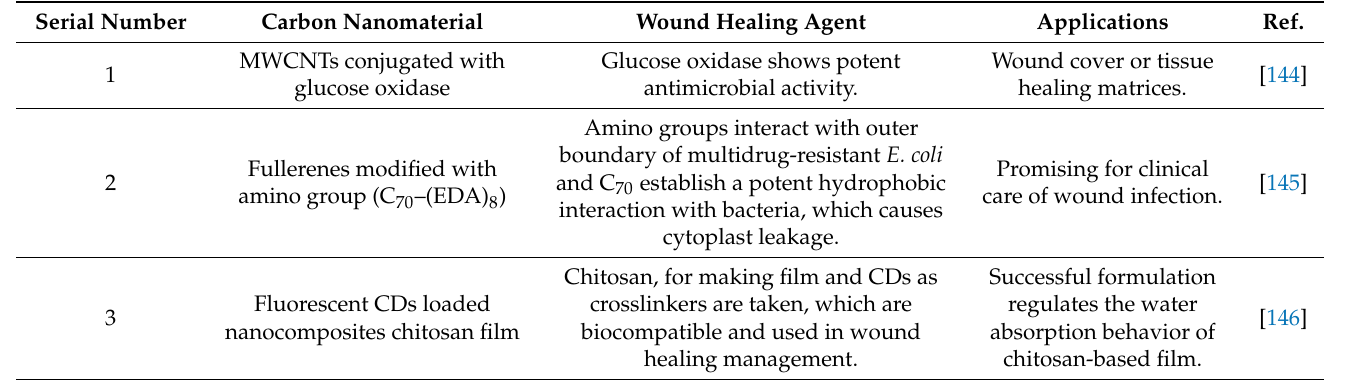
Table 5. Different uses of CNMs in wound healing